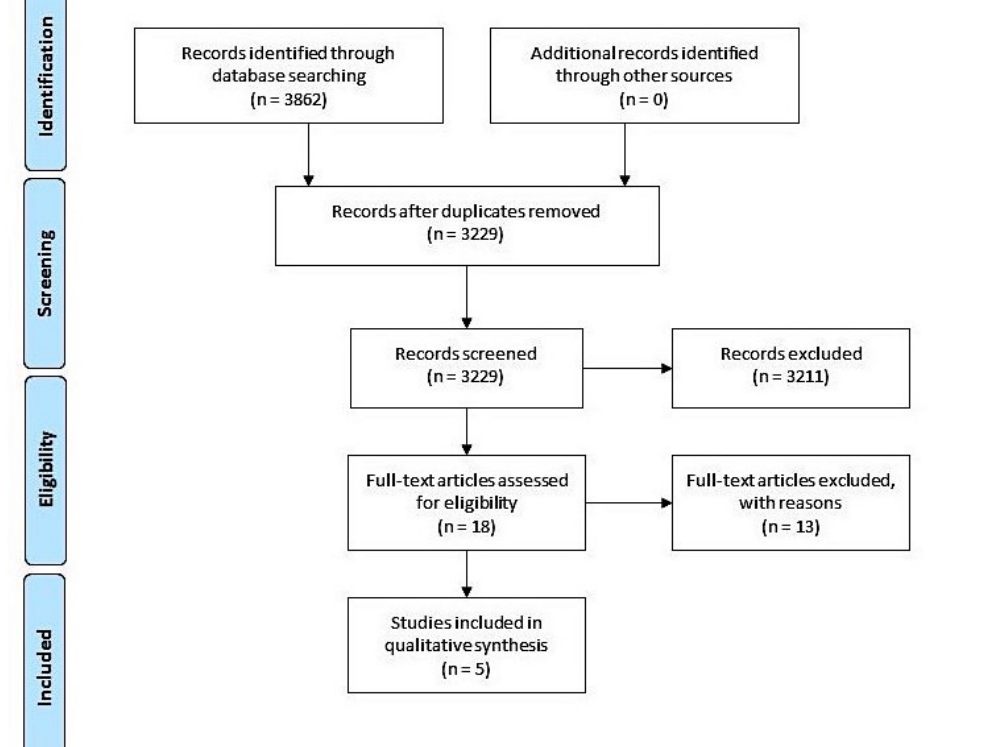
Figure 1. Systematic review of the literature flowchart.